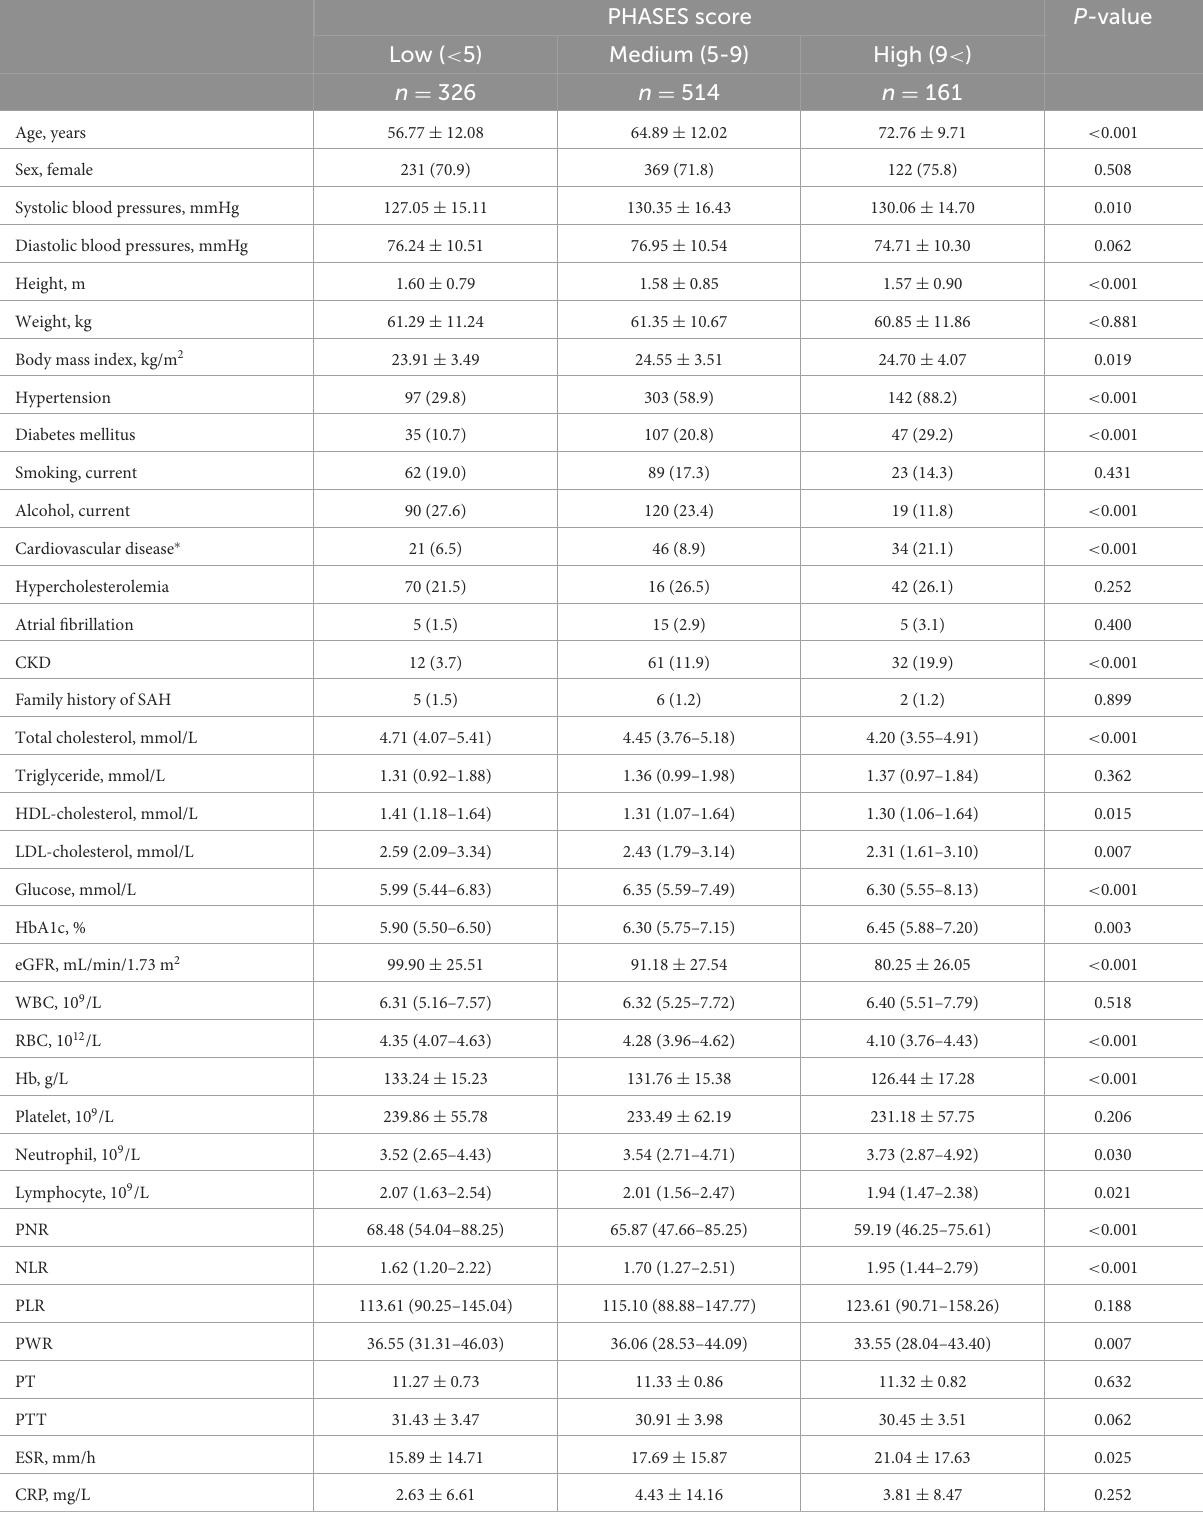
TABLE 3 Participant characteristics according to the PHASES